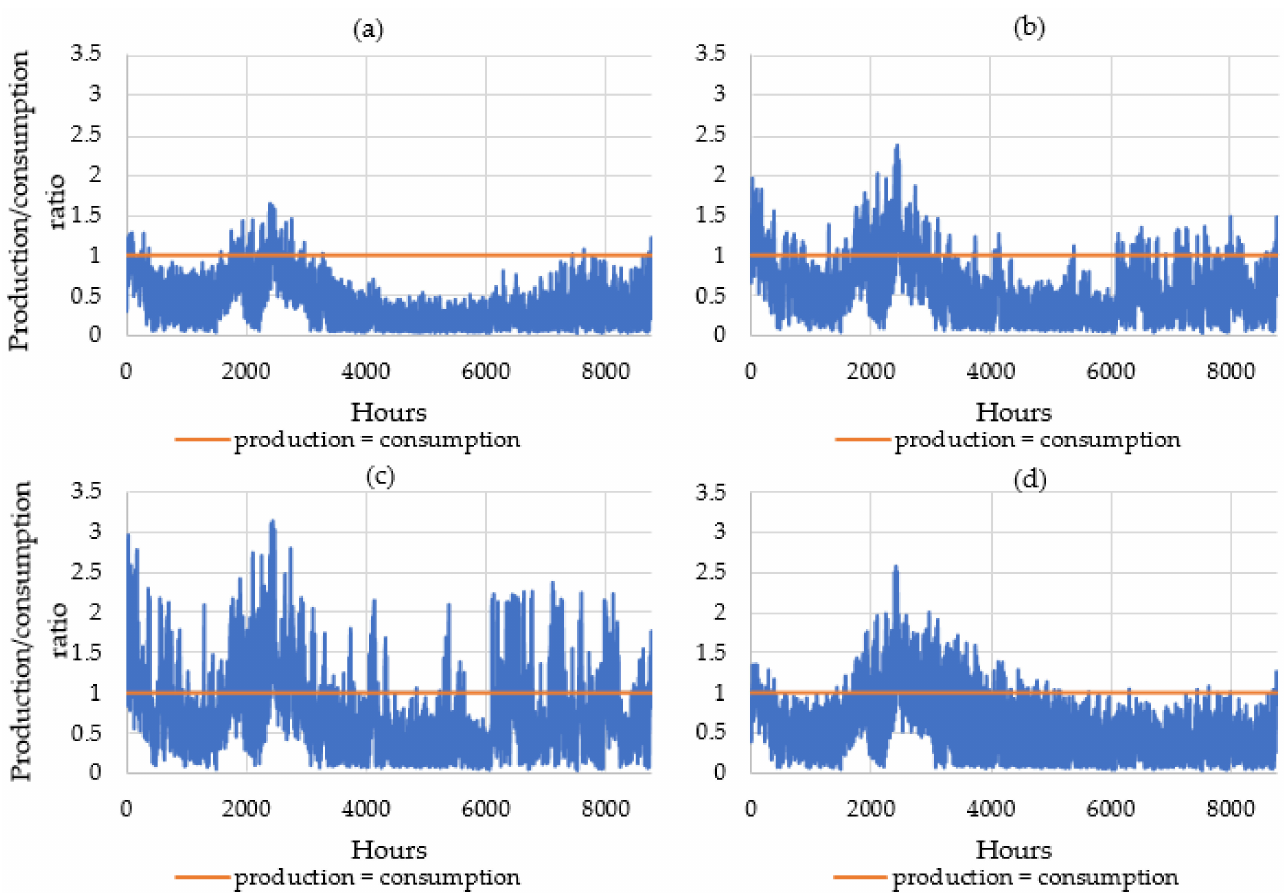
Figure 14. Hourly electricity production by resource type for different scenarios. ( a ) Scenario 1; ( b ) Scenario 2; ( c ) Scenario 3; ( d ) Scenario 4.